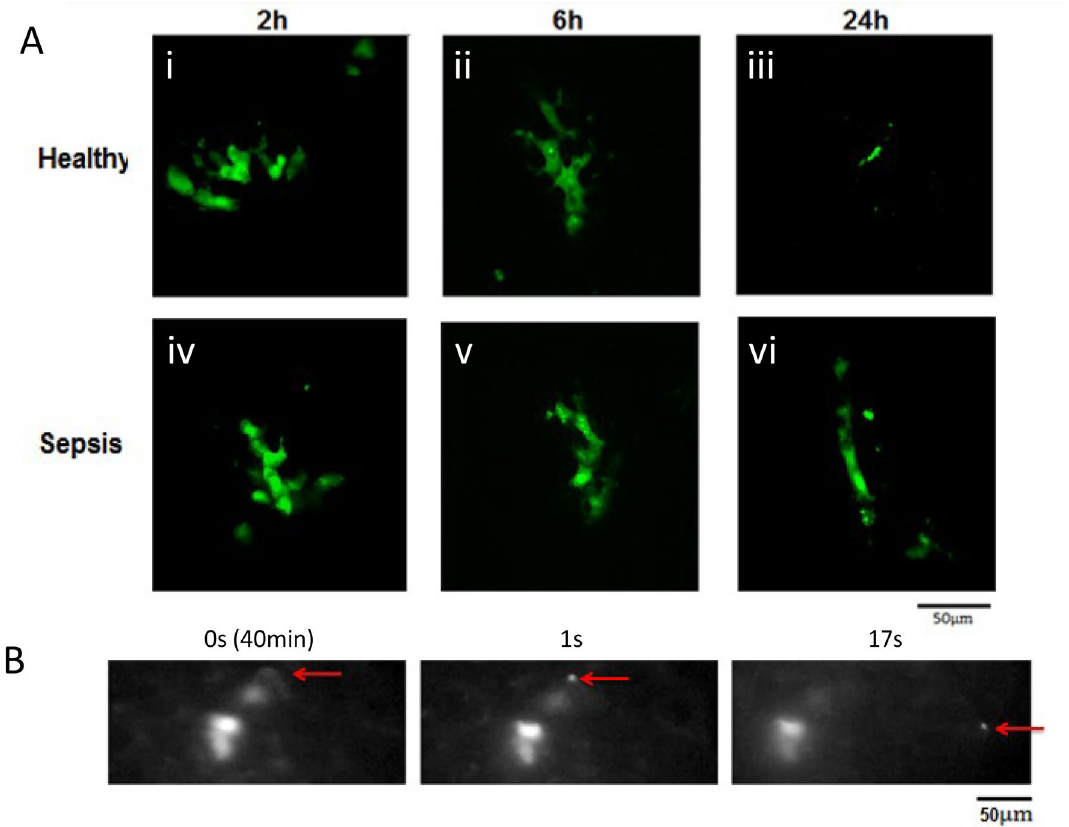
Figure 6. In vivo confocal microscopy allowed detailed analysis of cell structure at each time- point in healthy and pneumonia lungs with cell size differences discernibly evident at 24 h between MSCs in healthy and pneumonia lungs. The formation of micro-particles from the cells was indicated in post mortem confocal microscopy ( A ) and performing IVM using a 40X objective demonstrated the time-lapse release of fluorescent micro-particles (B, Red Arrow) approximately 40 min post cell administration IV ( B i-iii) IVM: Intravital Microscopy; MSC: Mesenchymal Stem